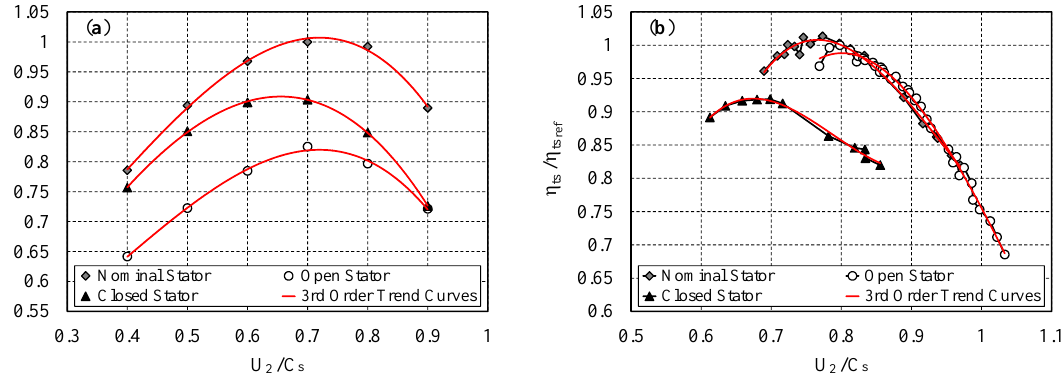
Figure 8. Evolution of the dimensionless total-to-static efficiency with regard to the blade speed ratio. ( a ) computational fluid dynamics (CFD) results for the MST turbine; ( b ) experimental results for the PTM